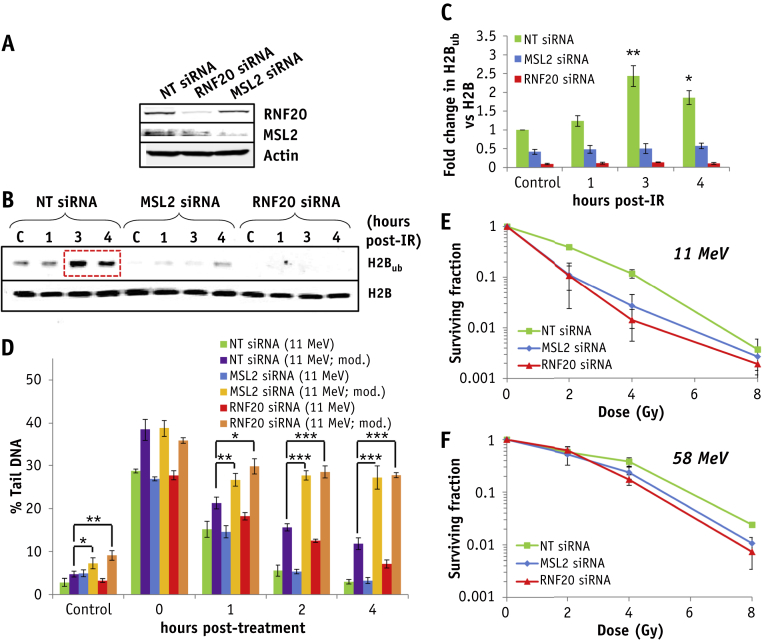
RNF20 and MSL2 catalyze formation of H2Bub in response to complex DNA damage (CDD) induced by high linear energy transfer (LET) protons. (A-F) HeLa cells were treated with non-targeting control siRNA (NT), MSL2, or RNF20 small interfering RNA (siRNA). (A) Whole cell extracts were analyzed by immunoblotting. (B, C) Cells were untreated (designated C) or irradiated with 10 Gy high-LET protons and harvested at the time points indicated after treatment and purified histones analyzed by immunoblotting. (C) Shown is the mean fold change ± standard deviation in H2Bub normalized against H2B. *P < .02, **P < .005, as analyzed by a one-sample t test of fold change in H2Bub versus the unirradiated control. Red box indicates increased levels of H2Bub. (D) HeLa cells were irradiated with 4 Gy protons at high LET and CDD measured at various time points after ionizing radiation by the enzyme-modified neutral comet assay after incubation in the absence or presence (as indicated by “mod”) of APE1, NTH1, and OGG1. Shown is the percent tail DNA values ± standard deviation. *P < .02, **P < .005, ***P < .001, as analyzed by a one-sample t-test. (E, F) Clonogenic survival of HeLa cells was analyzed after protons at (E) high LET and (F) low LET. Shown is the surviving fraction ± standard error. A comparison of the surviving fraction at 2 Gy (SF2) after NT siRNA versus MSL2 (P < .01) or RNF20 (P < .05) siRNA only after high-LET protons is statistically significantly different by one-way analysis of variance.